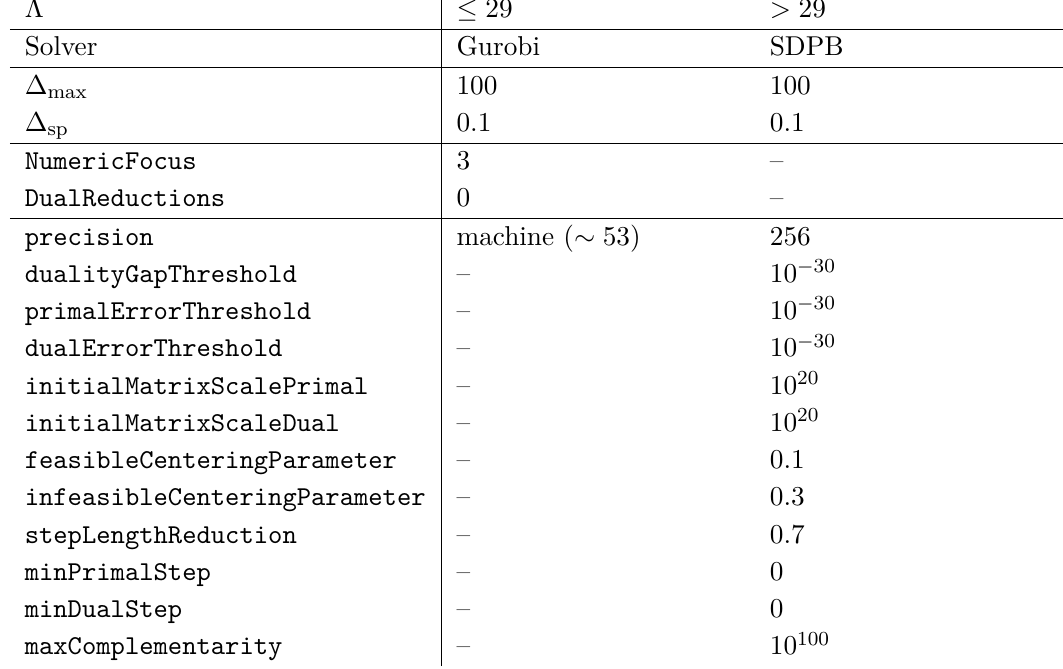
Table 1 . Parameters used in Gurobi and SDPB for the plots in this paper. All plots are at Λ = 39 , but lower Λ results are useful for getting preliminary estimates of bootstrap